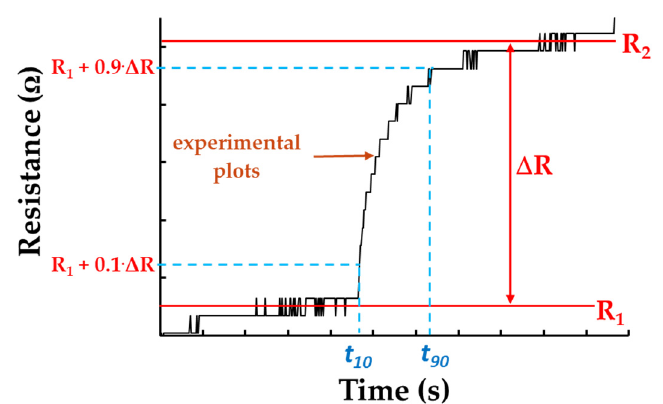
Figure 15. Example for calculation of response time.